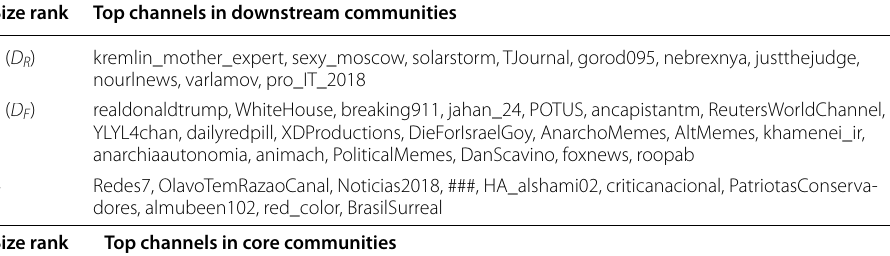
Table 2 Most important channels in the main downstream, core and upstream clusters for the network G 1 in Fig. 4 corresponding to the period Sep. 2015 to June 2019 Size rank Top channels in downstream